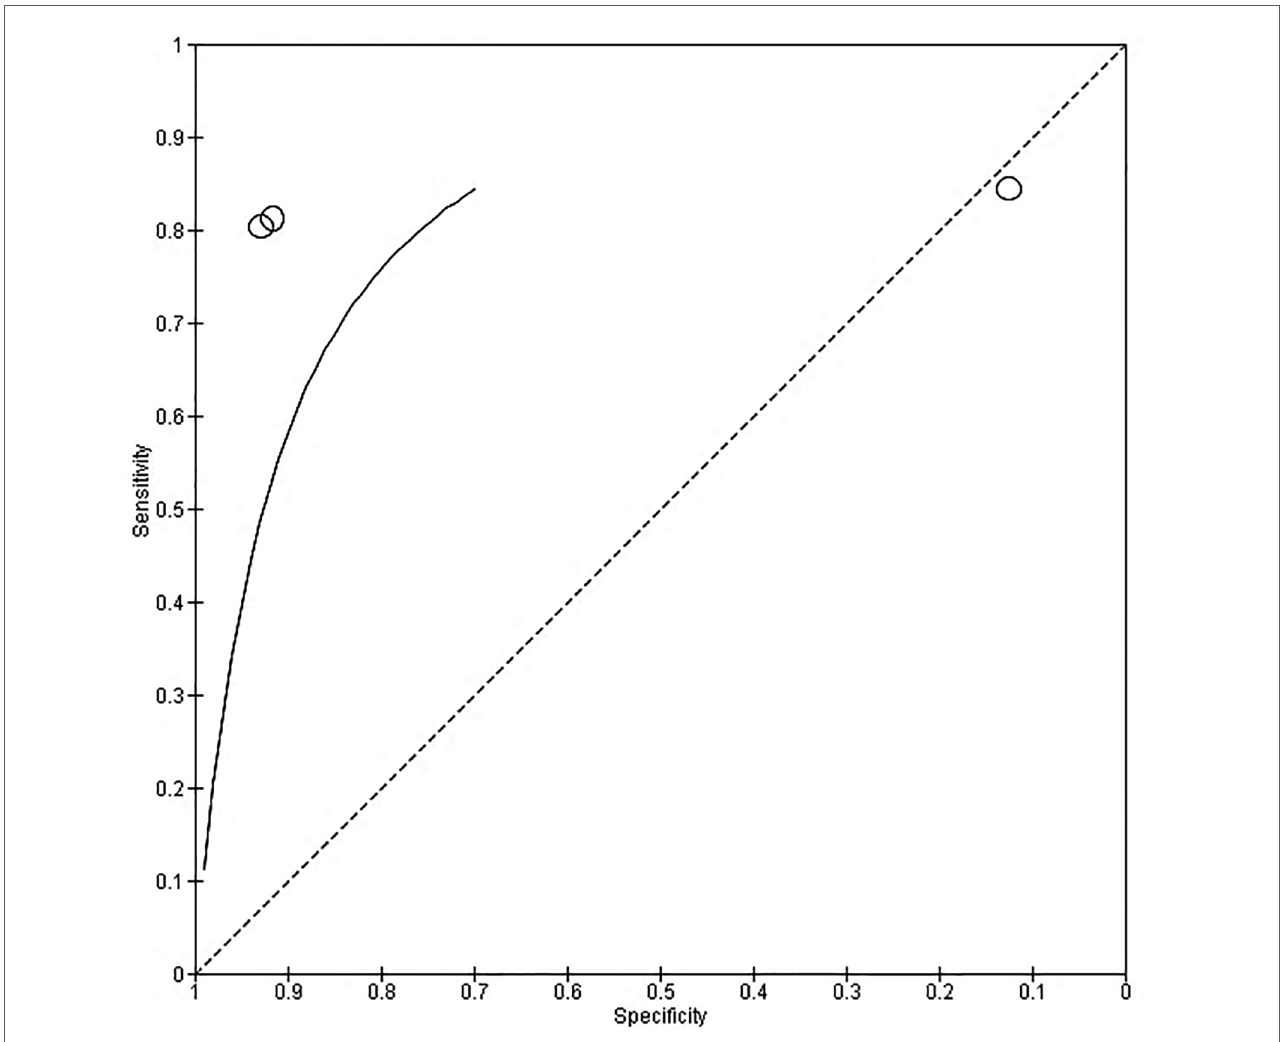
FIGURE 4 Receiver Operator Characteristic (ROC) curves obtained for CRDP